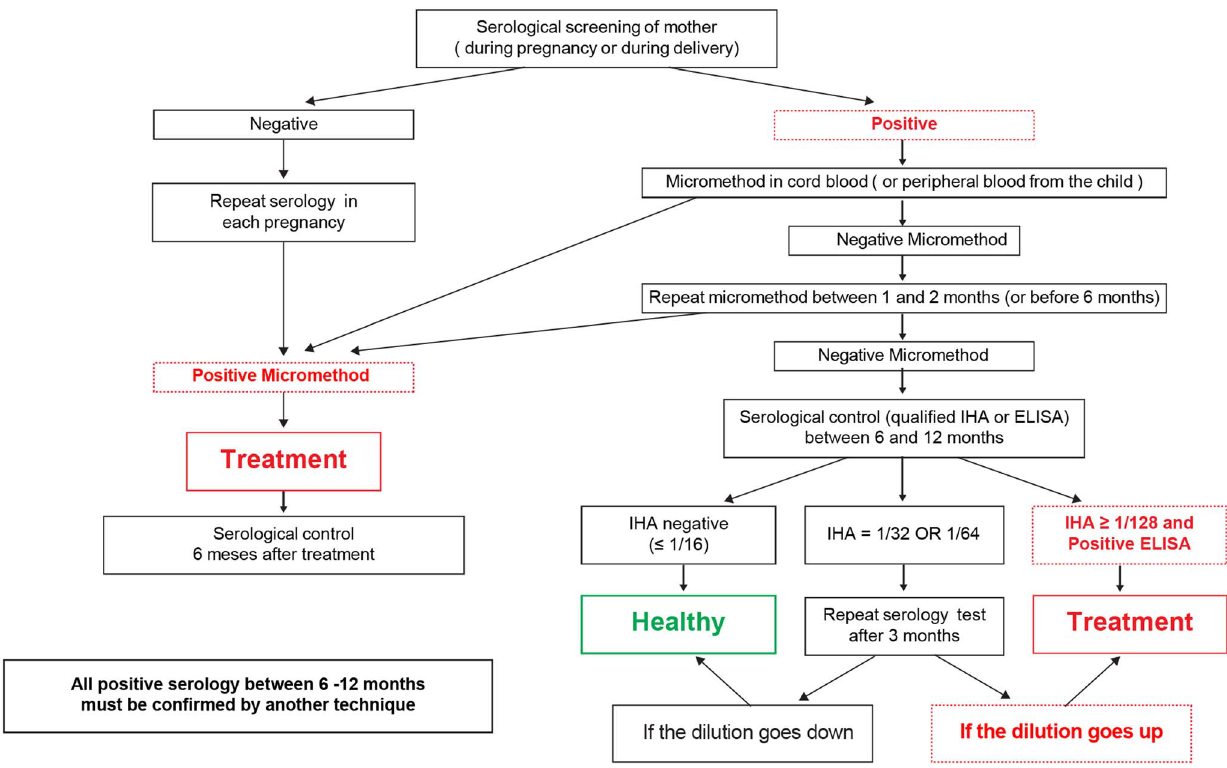
Figure 1. Diagnostic Diagram of congenital Chagas disease in newborns.